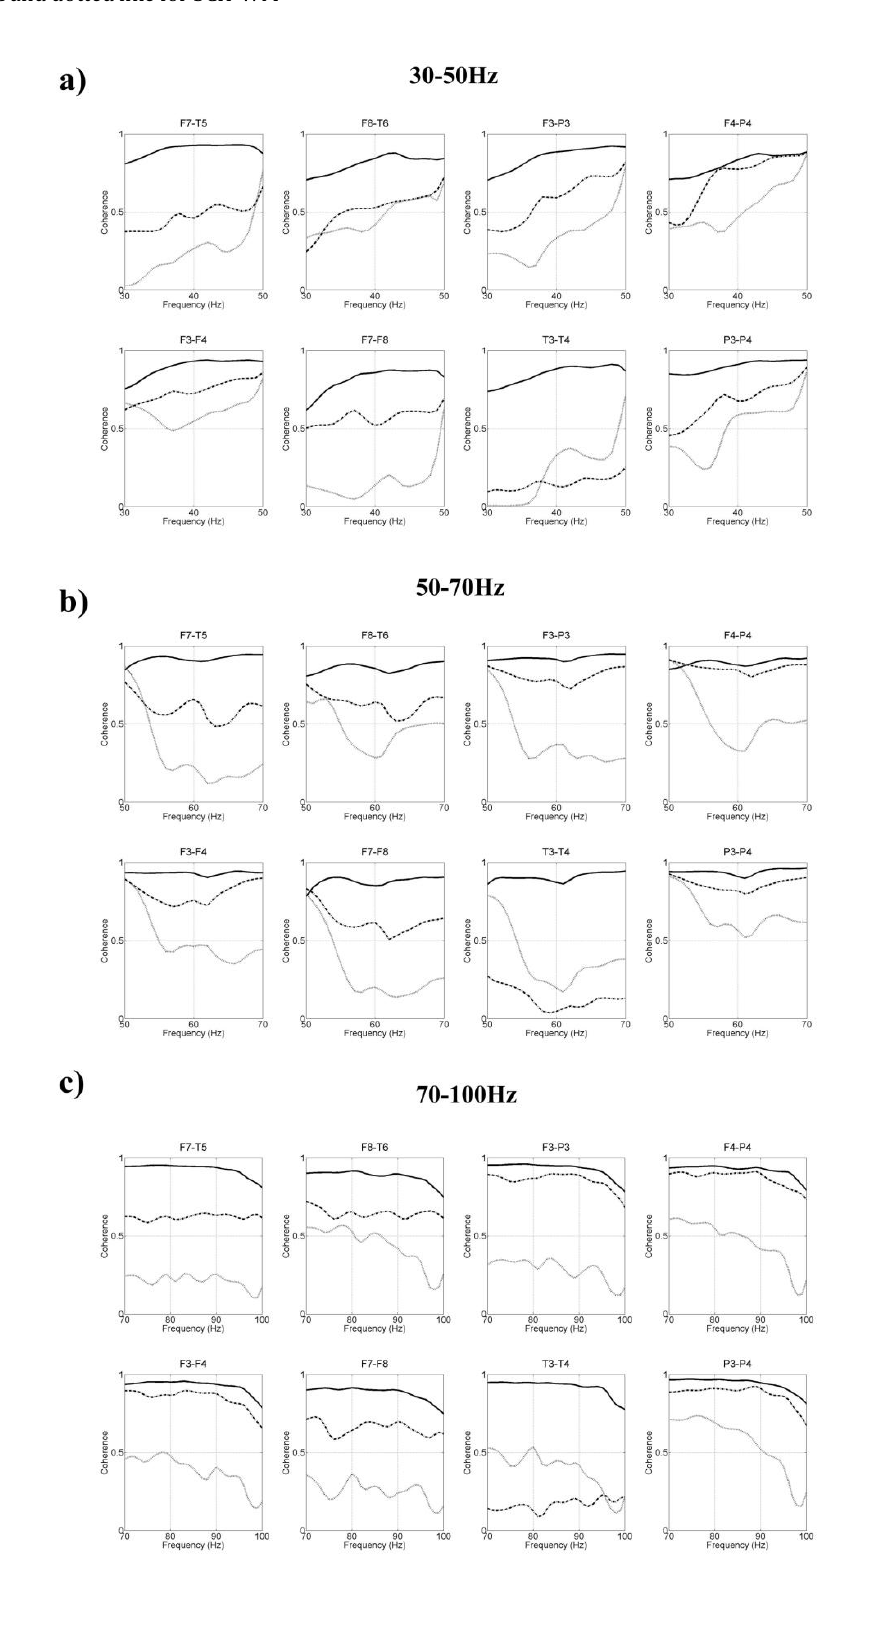
Fig.2 Three subplots (a,b,c) contain coherence distribution curves for three frequency bands 30-50Hz, 50-70Hz and 70- 100Hz. Every subplot is split into two rows where upper row contains coherence distributions for intrahemispheric electrode pairs and lower for interhemispheric pairs. Coherence distribution line styles are: solid line for SCH+WM, dash- dot line for HC and dotted line for